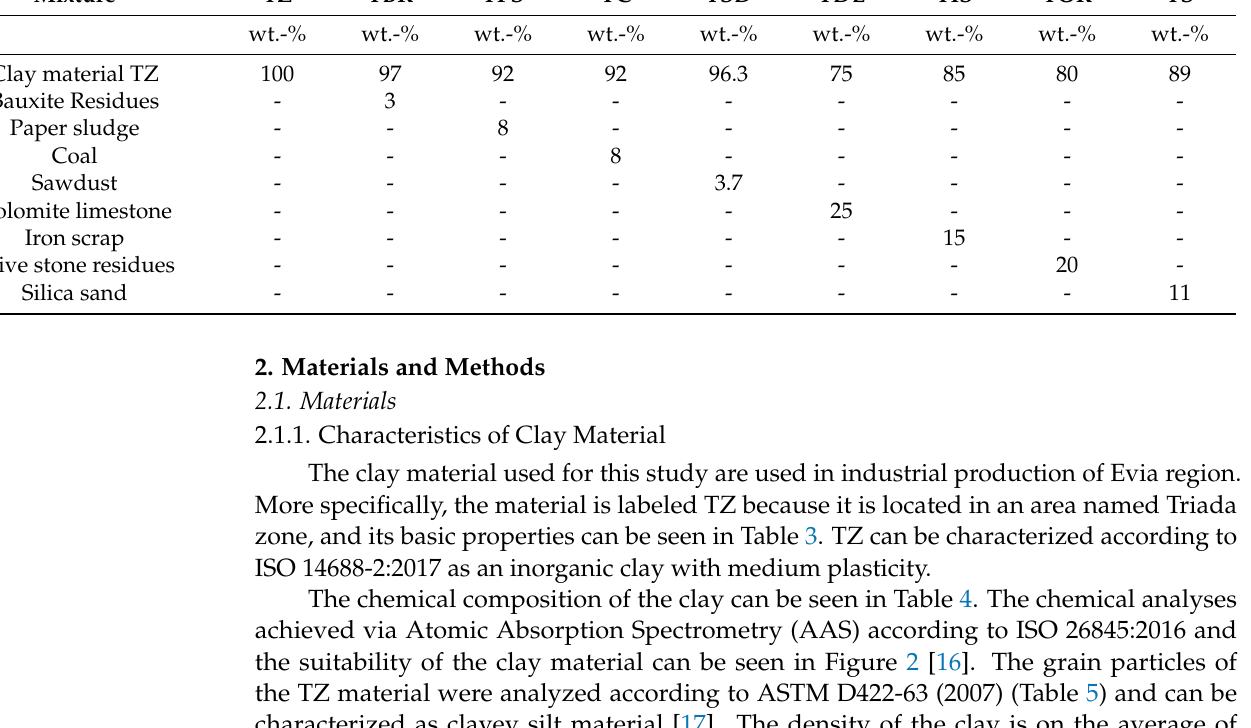
Table 3. Physical properties of TZ clay.